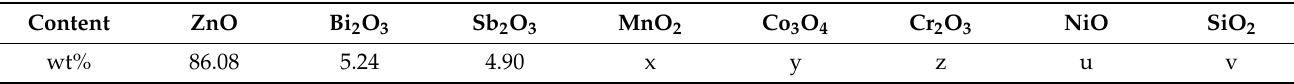
Table 1. Composition of ZnO Varistor